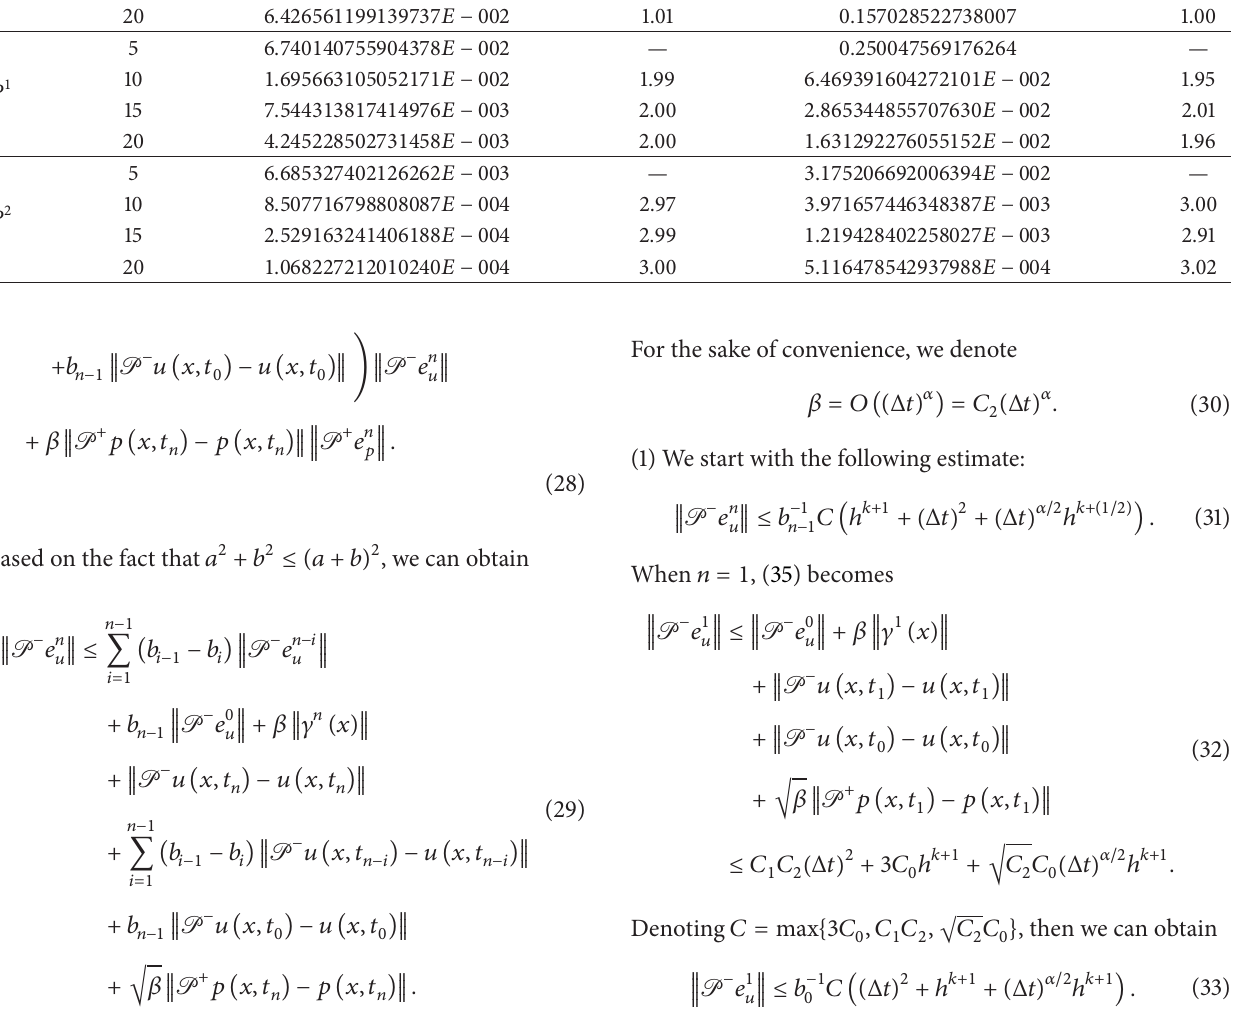
Table 6: Spatial accuracy test for the fractional order equation with the forcing term (42). 𝛼 = 0.6 , 𝑀 = 10 4 , 𝑇 = 1 . 𝑁 𝐿 2 -Error Order 𝐿 ∞ -Error Order 5 — 𝑃 0